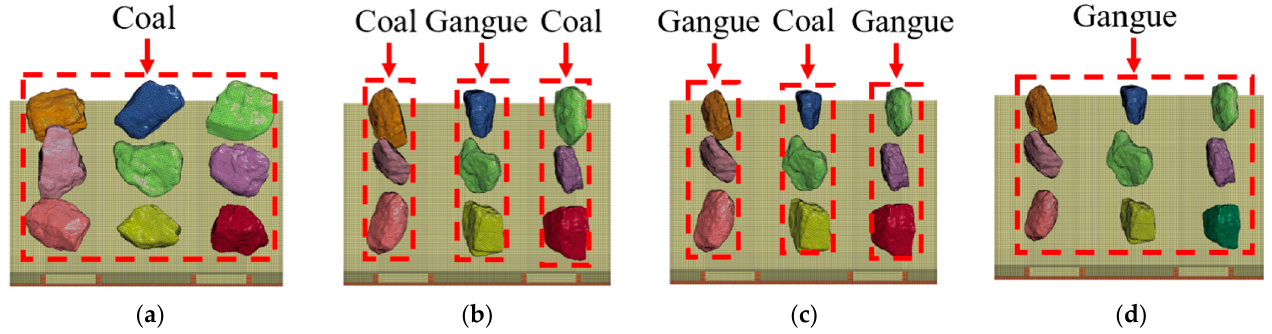
Figure 6. Four different RMR of coal gangue particles. ( a ) 0% ( b ) 33% ( c ) 66% ( d ) 100%.